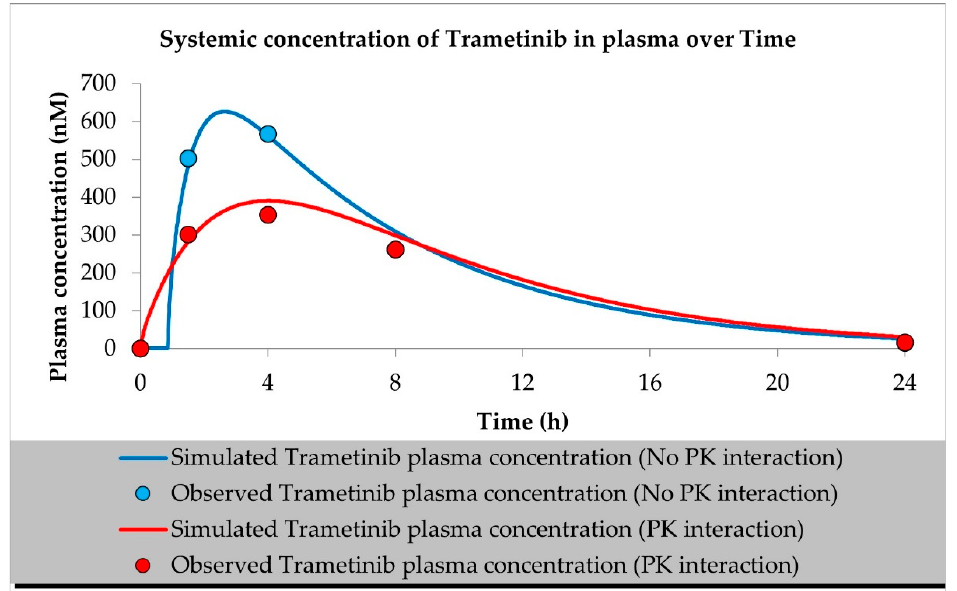
Figure 2. PBPK model of trametinib with and without PK interaction. Observed data are means from n = 3.